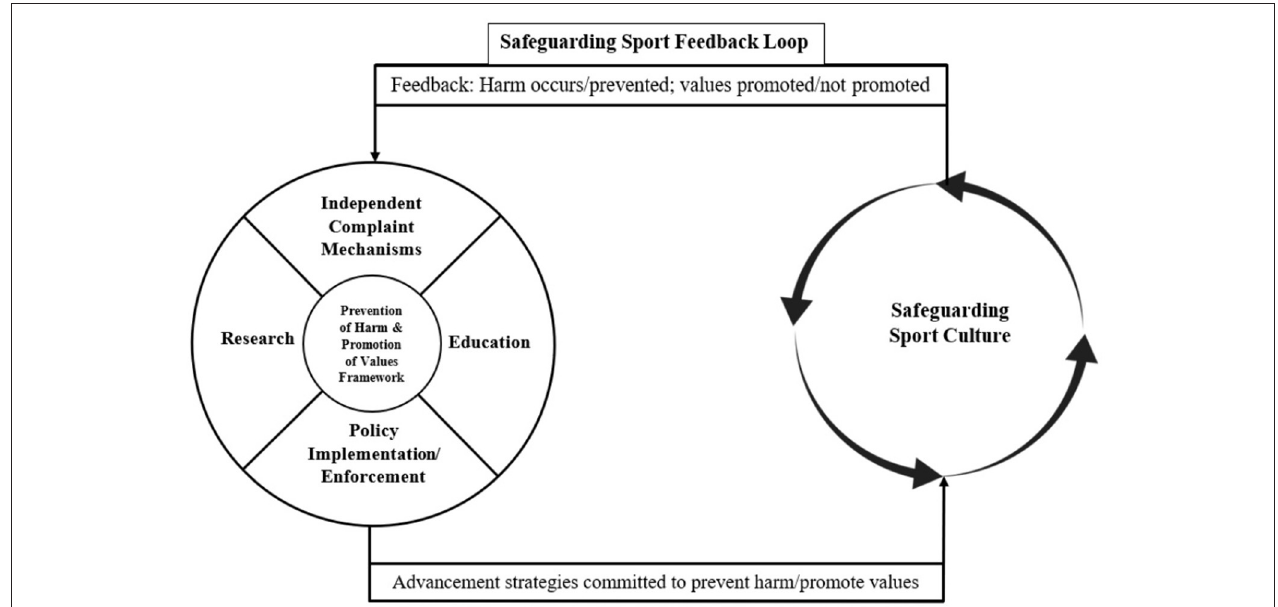
FIGURE 2 | Values-based framework for safeguarding